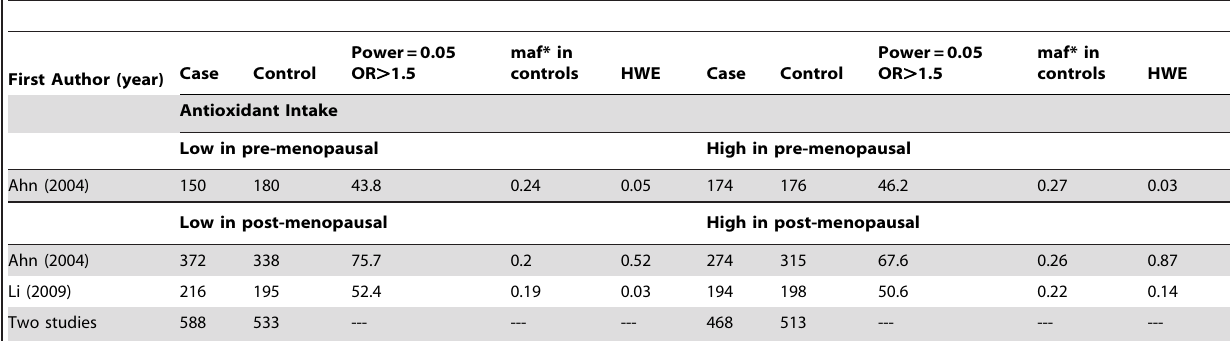
Table 3. Characteristics of the studies of MPO-G463A polymorphism and its association with breast cancer stratified by menopausal status and antioxidant